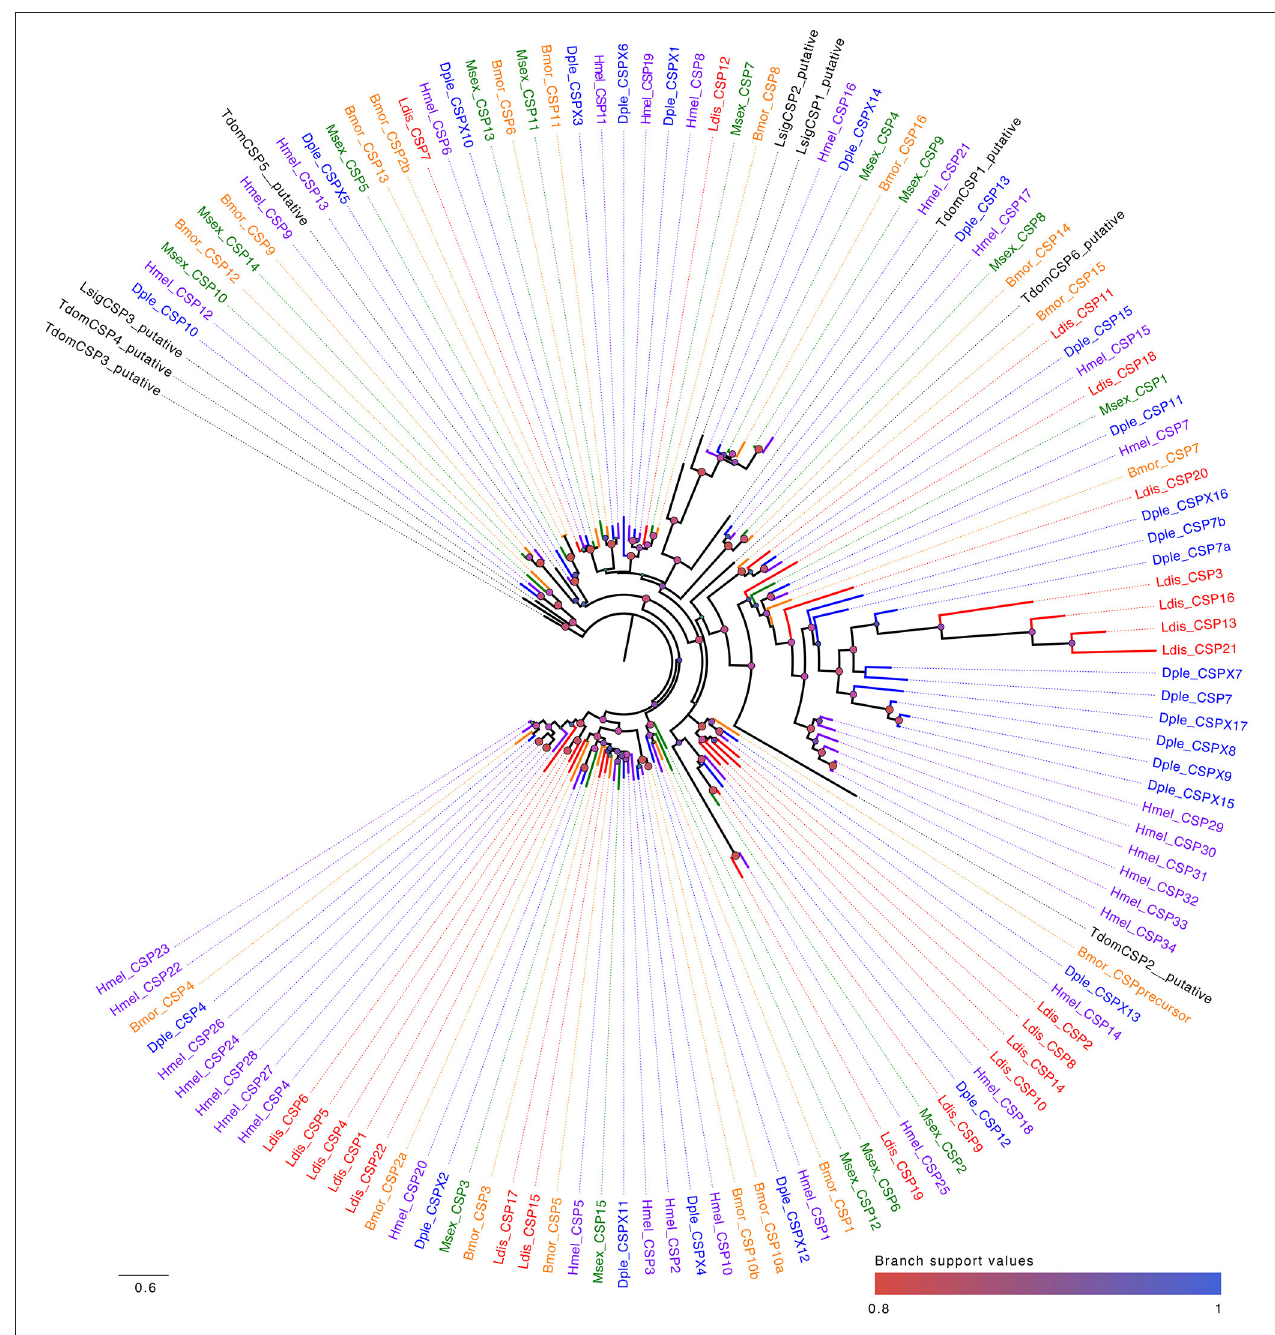
FIGURE 3 | Maximum likelihood dendrogram based on protein sequences of candidate chemosensory proteins ( CSPs ). Included are the putative sequences for Lymantria dispar (Ldis) plus those available for model Lepidoptera species Bombyx mori (Bmor), Danaus plexippus (Dple), Heliconius melpomene (Hmel), and Manduca sexta (Msex), we also included sequences from the Jumping Bristletail Lepismachilis y-signata (Lsig) and the Firebrat Thermobia domestica